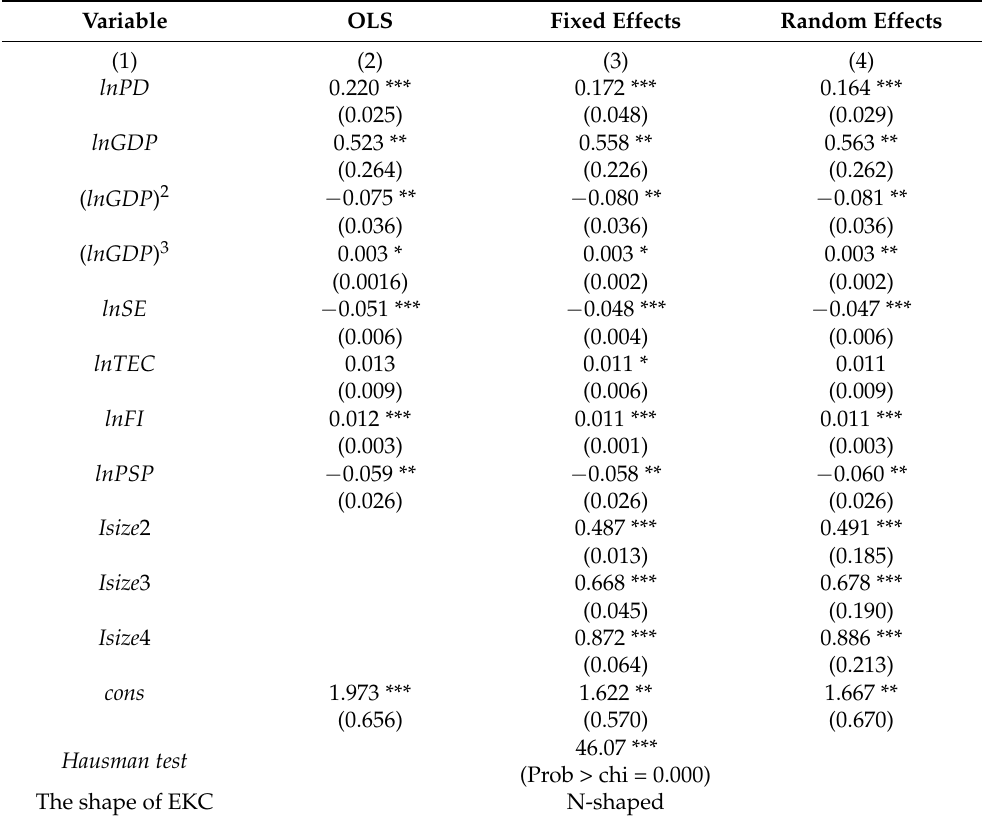
Table 4. Regression results of factors influencing urban PM 2.5